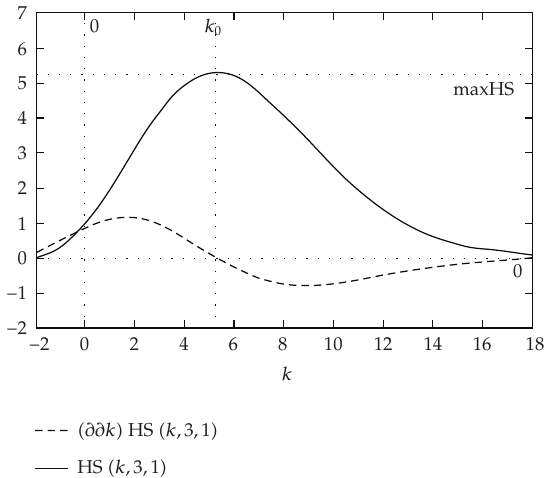
Figure 4: The contour function of the hyperspherical solid HS (cid:2) 3 ,n, 1 (cid:3) with the maximum value max HS and optimal degree of freedom k 0 (cid:2) for − 2 ≤ k ≤ 18 (cid:3)